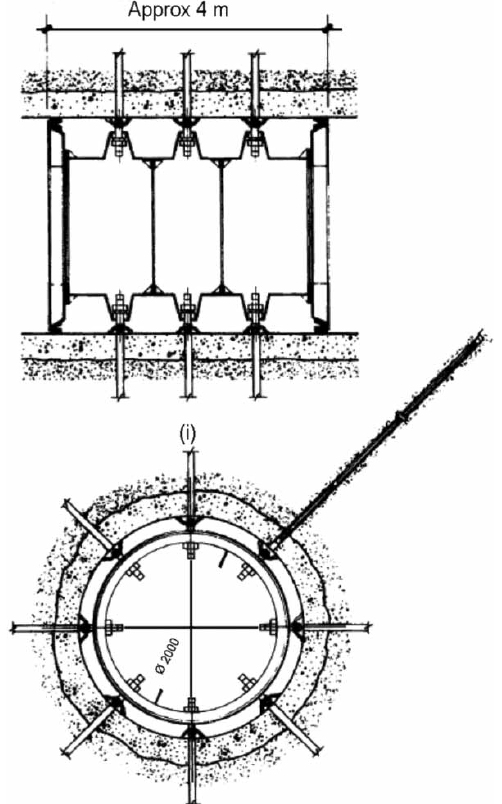
Fig. 2. Radial jacking test in a pressure chamber (ISRM